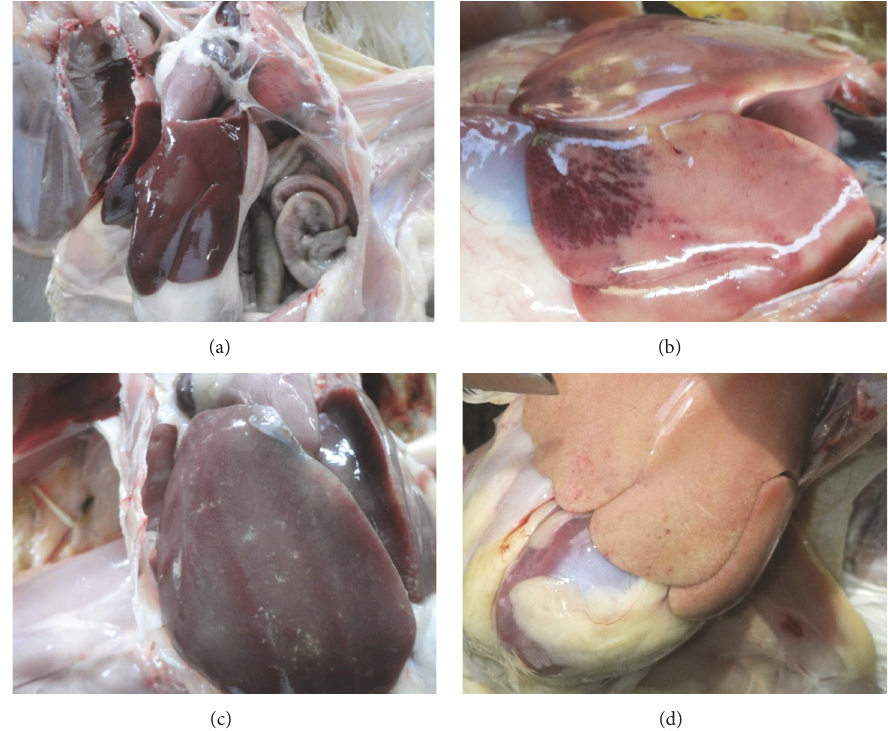
Figure 1: Macroscopic examination of the chicken’s liver on day 21. Chicken’s liver of group II showed a normal appearance with brown colour and smooth surface (6/6 samples) (a); group III showed the enlargement, obtuse angle, pale, and hemorrhage on its surface (6/6 samples) (b); group V showed the enlargement, obtuse angle, and pale (2/6 samples) (c); group VI showed a yellowish colour, and it was suspected due to fatty degeneration (1/6 samples)